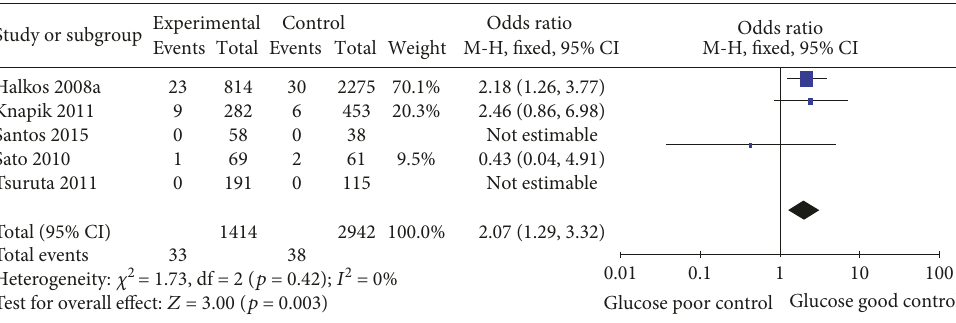
Figure 4: Forest plot of the relationship between HbA1c level and stroke.